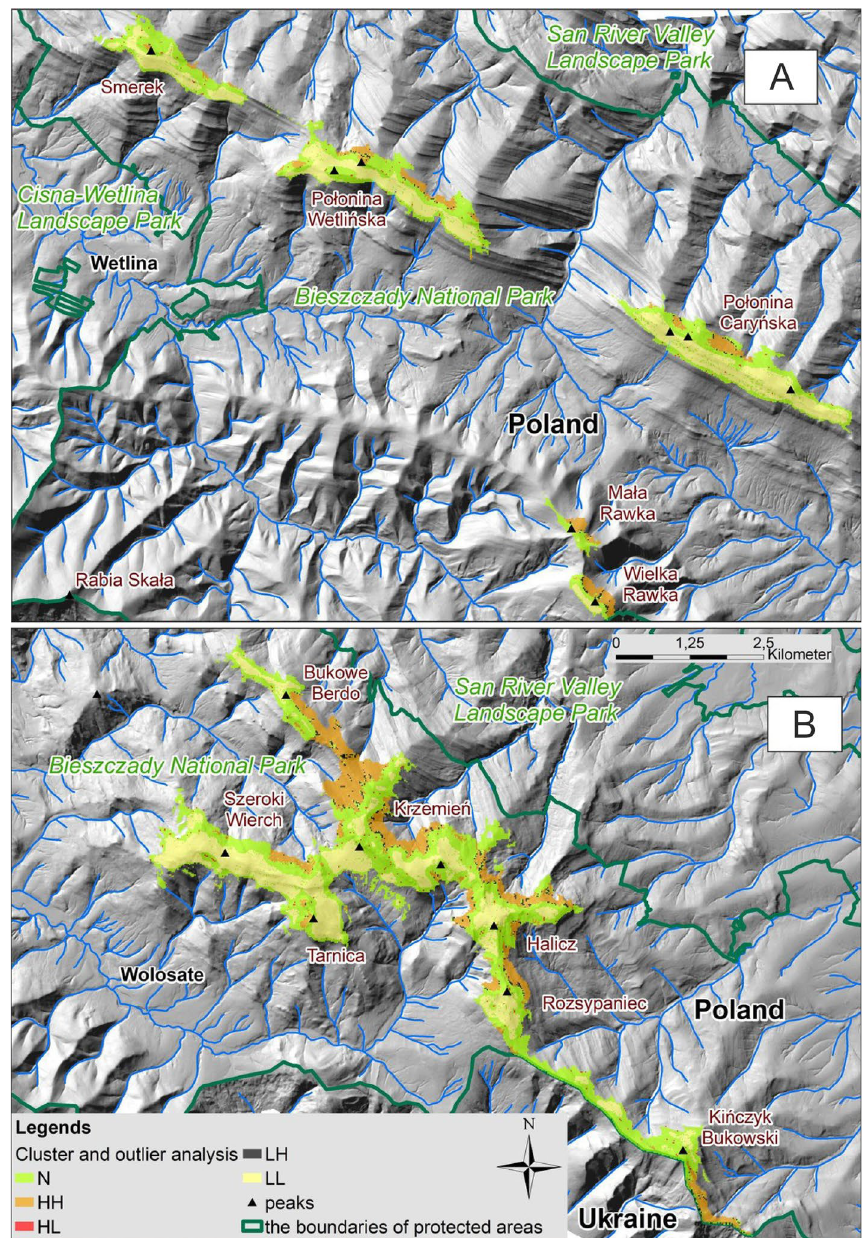
Figure 5. Distribution of cells depending on the classification of clusters according to the Anselin Local Moran’s I statistic. ( A ) Part N-W of the Bieszczady National Park; ( B ) part S-E. Cluster types as in Fig. 4. Credit: Map generated with QGIS Version 3.20 (https:// www. qgis.